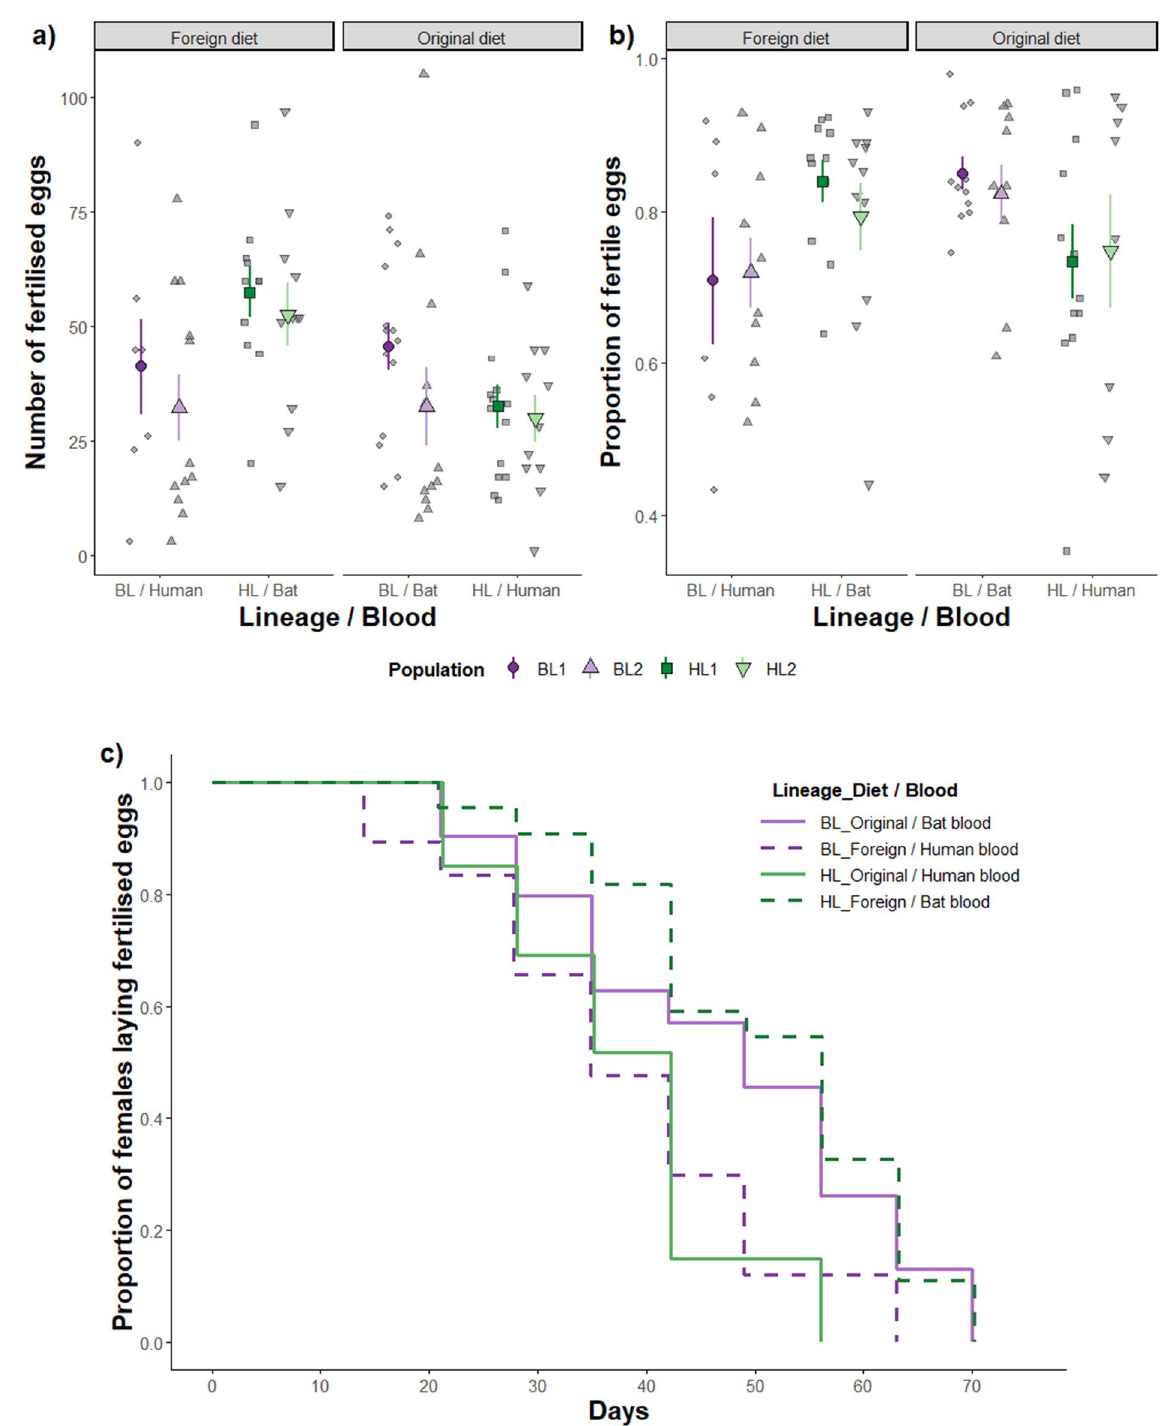
Figure 1. Effect of male diet (original or foreign, resp. bat or human blood) on male fertilisation success after a single mating with tester female in two different bedbug lineages (bat (BL, purple colour) or human (HL, green colour)). ( a ) The number of fertilised eggs and ( b ) the proportion of fertilised eggs (after exclusion of females laying only fertilised eggs) depended on the interaction of male diet and genetic origin. Different colour shades and point shapes with error bars show the mean and standard error for the individual male population. Grey symbols represent individual data points. ( c )Induction of female infertility (more than 50% unfertilised eggs/ clutch) changed with respect to male diet (solid lines correspond to the original diet, dashed lines to foreign diet) and